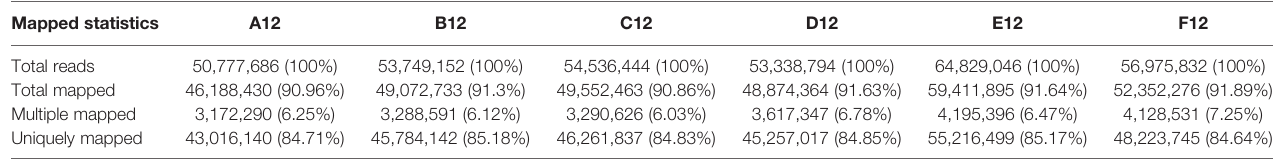
TABLE 1 | The comparison result with clean data and Rattus genome sequences. Mapped